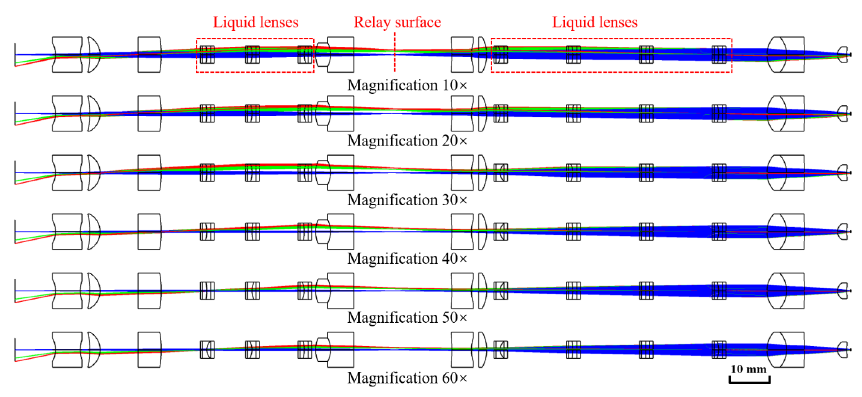
Fig. 3 Simulation results of the zoom objective lens at the magnifications of 10 × , 20 × , 30 × , 40 × , 50 × , and 60 ×